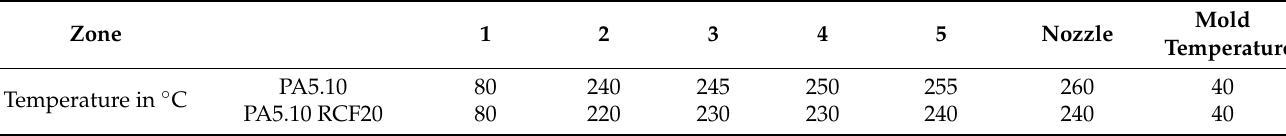
Table 3. Temperature profile of the injection molding